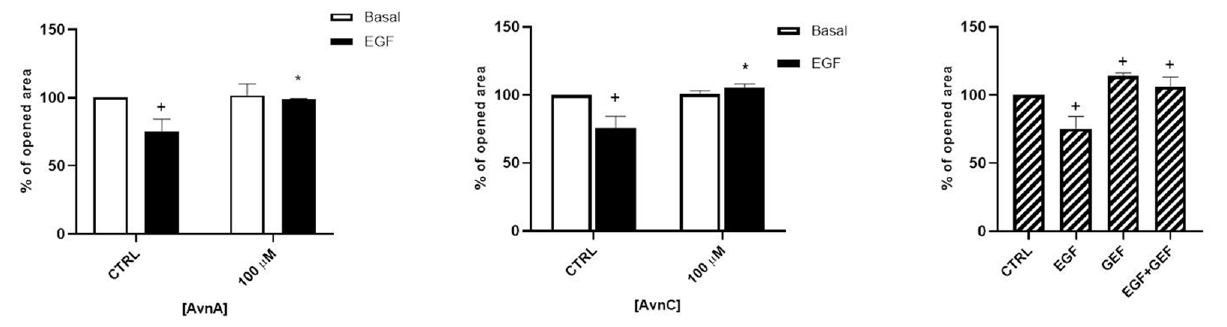
Figure 4. Avns reduce migration of tumor cells promoted by EGF. A549 migration was evaluated by scratch assay. Data are reported as % of opened area over basal control and are representative of three independent experiments run in triplicate. Statistical analysis: + p < 0.05 vs. CTRL and * p < 0.05 vs. EGF.